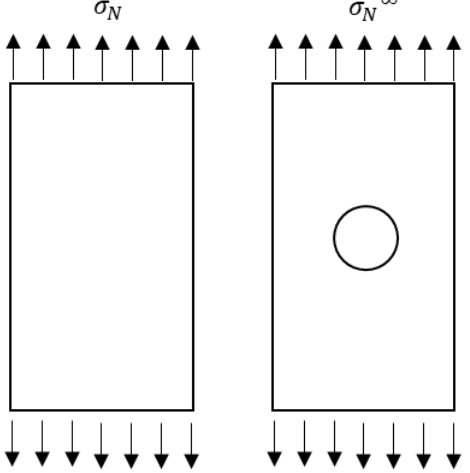
Figure 5. Applied stress within the crack regions of unnotched as well as notched samples.